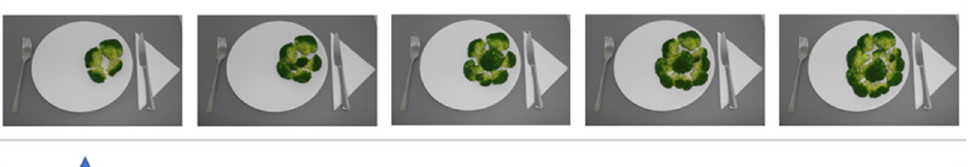
Figure 2. Example of five pictures with increasing portion sizes of broccoli. The sliding triangle was used to estimate the “normal” portion size of each of the five vegetables and each of the five